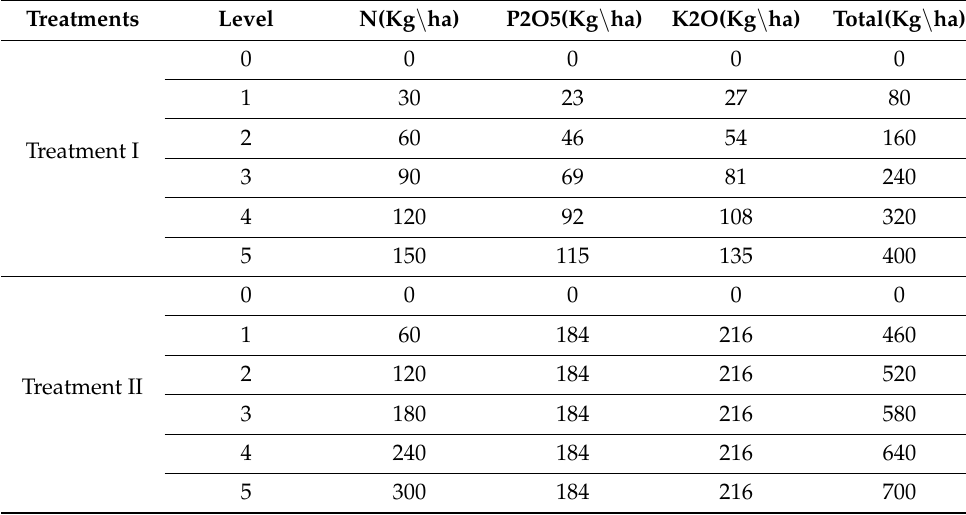
Table 1. Types of the fertilizer used in this study. Treatments